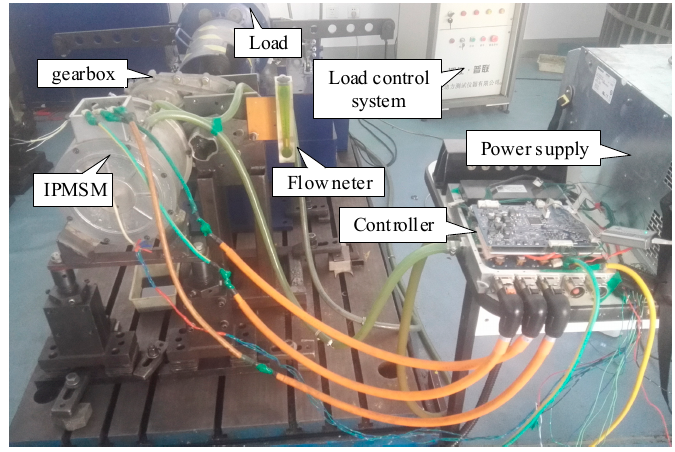
Figure 10. Experimental platform.